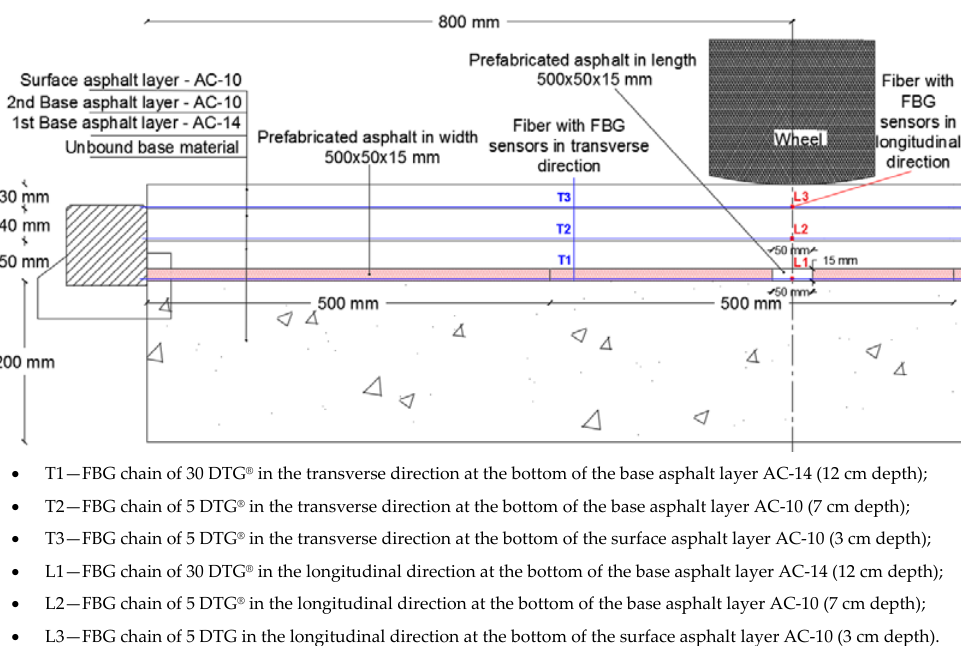
Figure 3. FBG configuration in three asphalt pavement layers (cross-section of road) [16].